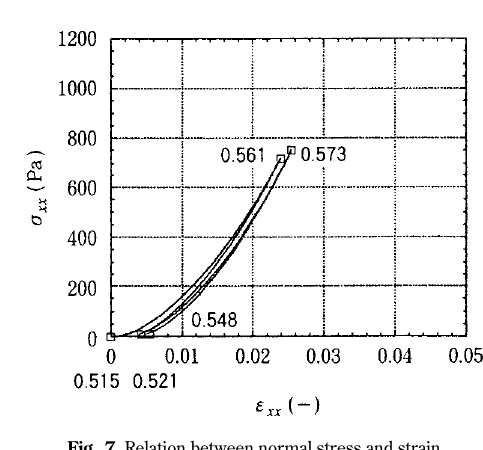
Fig. 6 . Relation between normal stress and strain (random packed, F = 30 m w g)